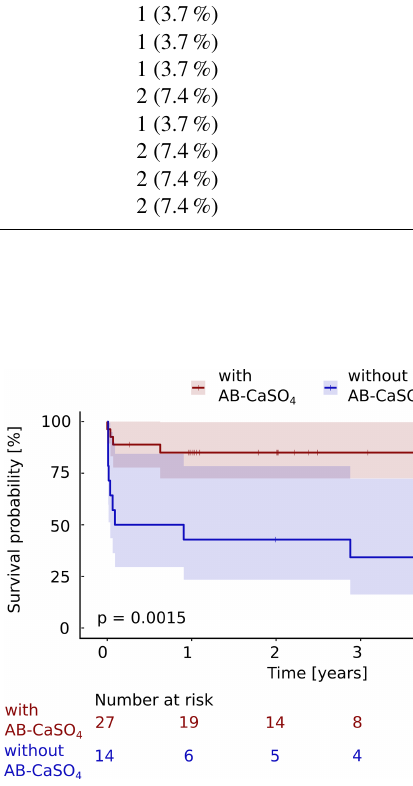
Figure 3. The Kaplan–Meier cumulative survival curves of 41 pa- tients with PJI of the hip treated by DAIR procedure are shown and are stratified by treatment with and without local application of antibiotics with CaSO 4 as the carrier material. The end point was defined as any reoperation, including DAIR or exchange, later than 72h after the first DAIR. DAIR repeated within 72h was accepted as a second look and was not counted as a failure. The survival data were compared using the log rank test. A significantly ( p < 0 . 0001) longer infection-free cumulative survival could be observed in the intervention group compared to the control group. The confidence interval indicated corresponds to a 95% confidence interval. The Cox proportional hazard ratio over the whole study period was 8.9 (95% CI 2.8–28.2) for this analysis, favoring the addition of AB- CaSO 4 .